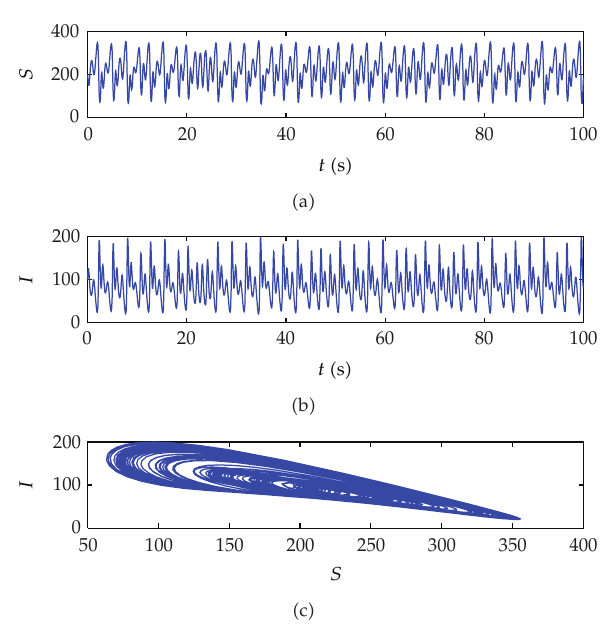
Figure 1: Typical chaotic attractor for the model